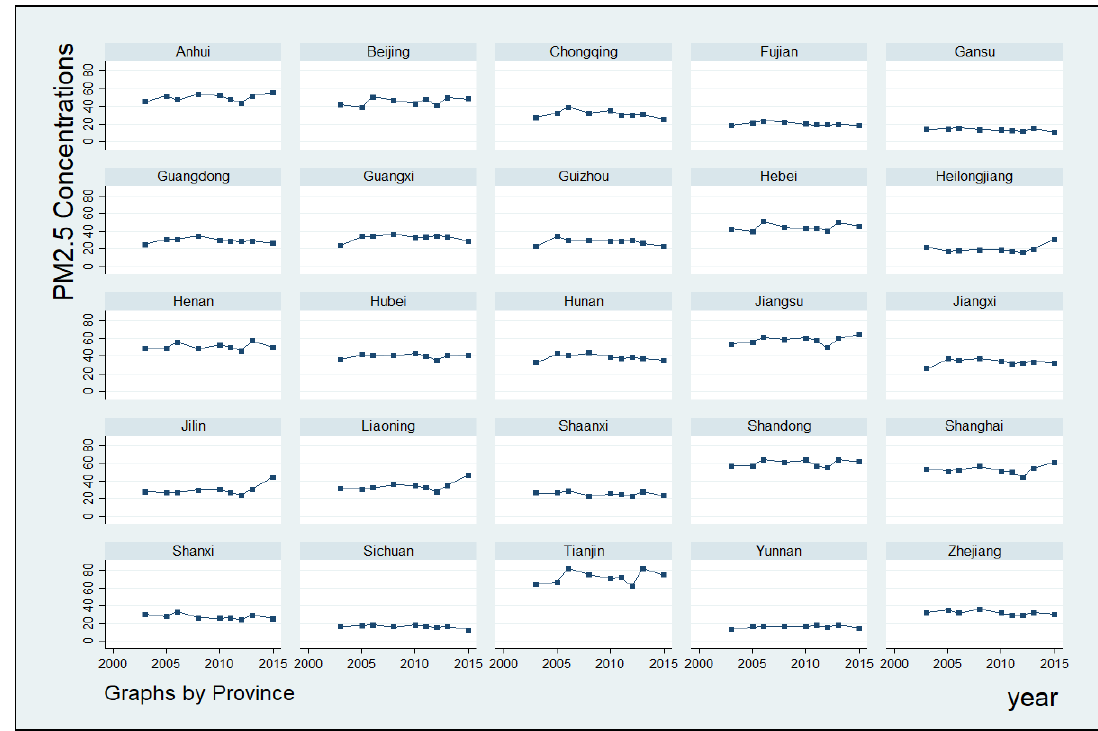
Figure 2. Annual Average Ground-level PM 2.5 Concentrations in the Chinese Provinces.